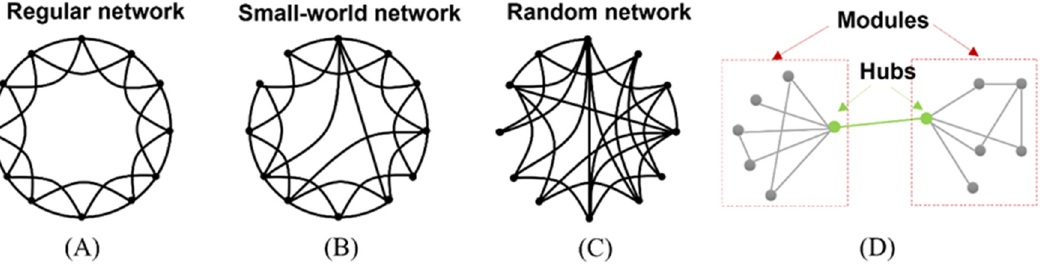
Figure 2. Different kinds of networks and the graphical introduction of nodes and links: ( A ) Regular network; ( B ) Small-world network; ( C ) Random network; ( D ) Graphical introduction of hubs and modules.